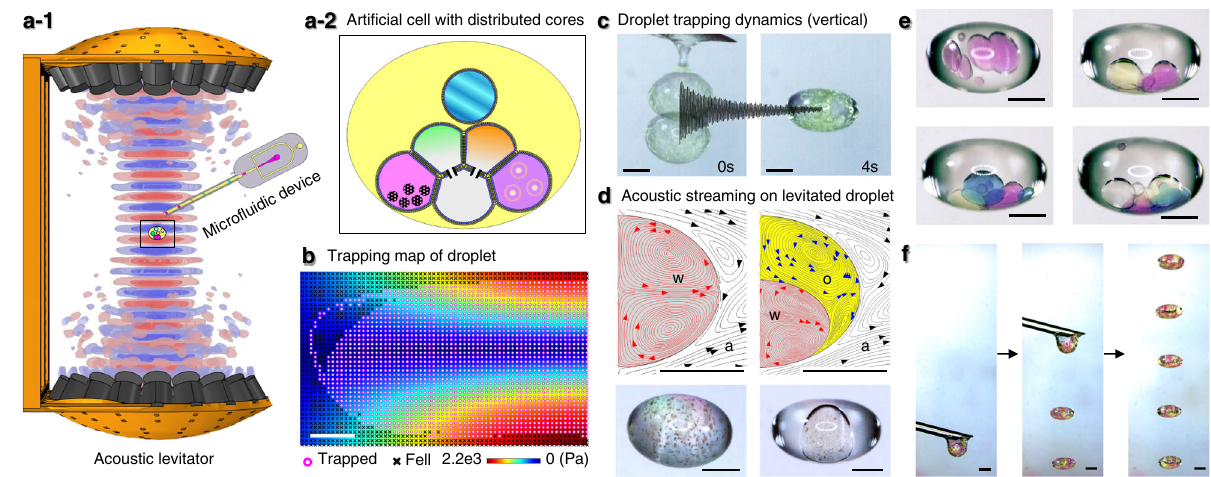
Fig. 1 Droplet laboratory platform. a - 1 Schematic of the acoustic levitator platform setup. Multiple acoustic standing waves (red and blue), generated by the acoustic levitator, can trap micro fl uidically formed arti fi cial cells with distributed cores (ACDC droplet), at nodal positions. Photographs of full experimental apparatus are available in Fig. S1. a - 2 Schematic of patterned ACDC droplets encapsulating multiple reagents within the core networks. b Simulation results of 2 mm diameter droplet trapping in air. The pink circle (droplet levitated) and the black cross (droplet fell) symbols represent the outcome of simulated droplet release positions in the acoustic fi eld (rainbow colour map indicates standing wave pressure pro fi le (symmetric half)). c Droplet trapping dynamics: An ACDC droplet dispensed from the micro fl uidic device into a standing wave fi eld oscillates vertically in the standing wave node before dampening and assuming a stable position over a period of 4 s. Additional data on droplet release positions are available in Fig. S2. d Top; Simulation and experimental results of the convective fl ows within levitated water (w) droplet in air (a) (left) and water in oil (o) double emulsion droplets in air (a) (right). Bottom; Water phases containing hydrophilic magnetic microparticles (dia. 1 μ m) and minor aggregates (brown), remain suspended and circulate with the fl uidic convection, without signi fi cant clustering. e Manually adding multiple water droplets to a levitated oil droplet with a micropipette. From top left to bottom right, pink, green, blue and clear droplets. f Deposition of multiple micro fl uidically formed ACDC droplets at sequential nodes within the acoustic standing wave fi eld. Scale bars = 1